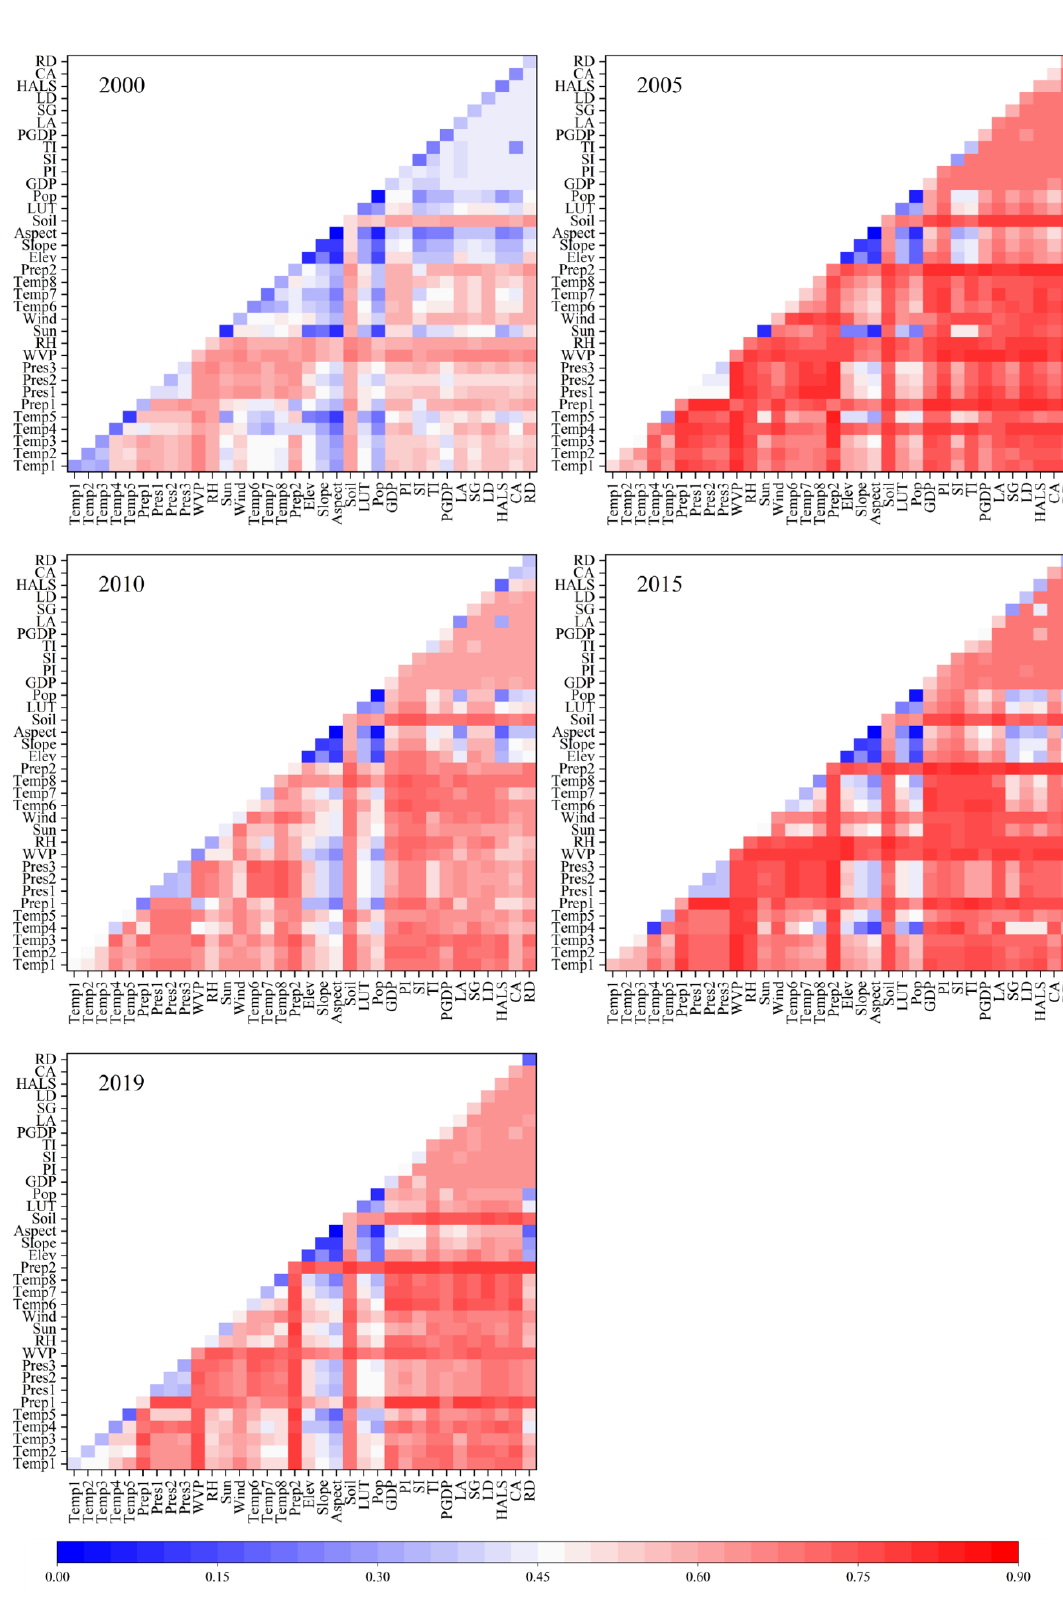
Figure 8. Interaction detection results in different years of different driving factors.